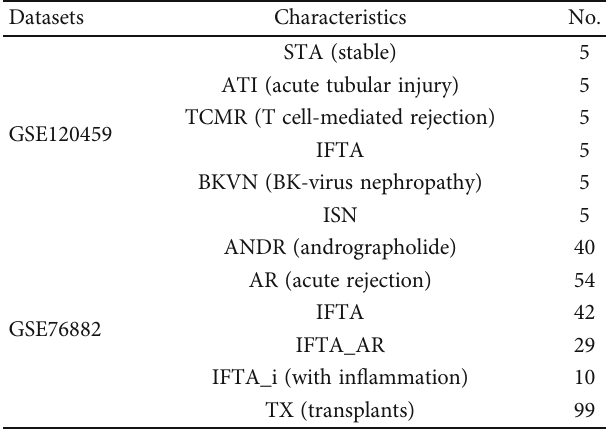
Table 1: The clinical characteristics of patients in the GSE120459 and GSE76882